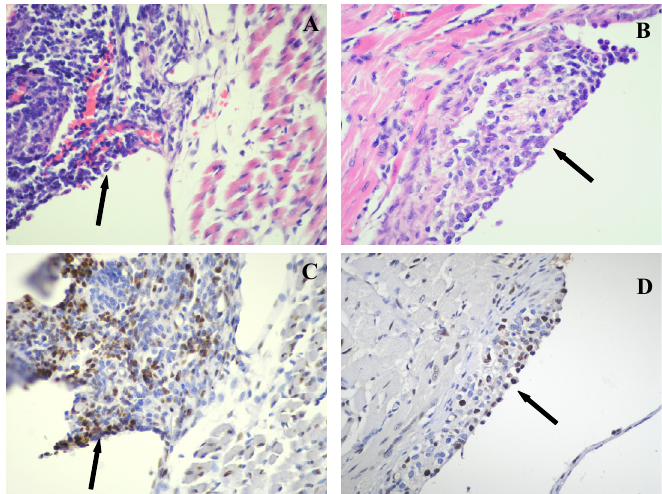
FIGURE 1 - Photomicrograph of histological sections of the fetal trunks with heterotopic brain tissue (arrows) stained with Hematoxylin and Eosin and submitted to immunohistochemical reaction with PCNA antibody. A and C are from E18 group, whereas B and D are from P8 group. Note the less intense immunostaining in P8 group when compared with E18 group, both with fragments implanted over the parietal pleura (arrows). (A e B: Hematoxylin and eosin staining; C and D: Immunohistochemical reaction using the ABC method with the primary PCNA antibody; developed with DAB, 400X original magnification) A